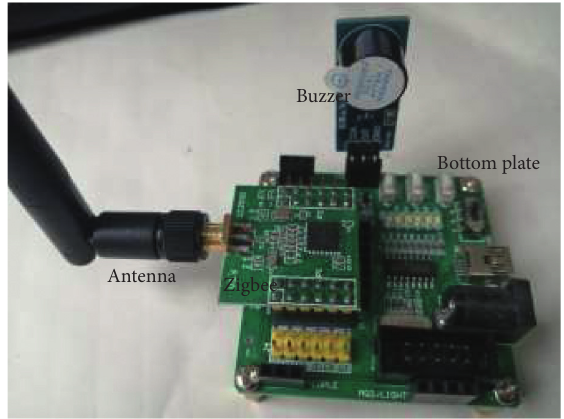
Figure 10: zigbee node.